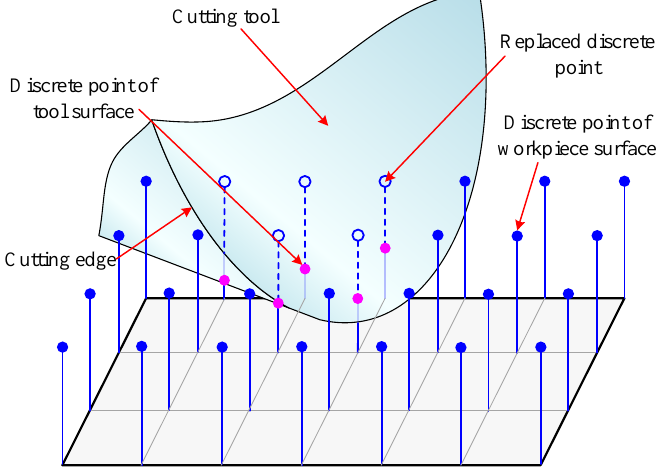
Figure 16. Replacement principle of discrete points between the cutting tool and workpiece sur- face.